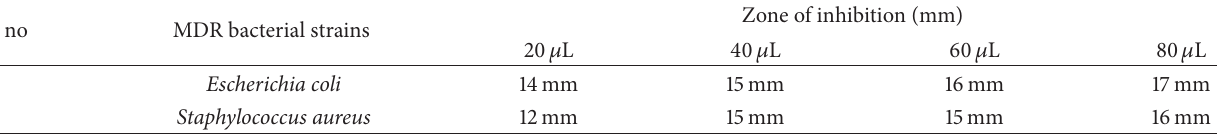
Table 1: Zone of inhibition of AgNps produced by the endophytic fungi Penicillium sp. against MDR E. coli and S. aureus . S.